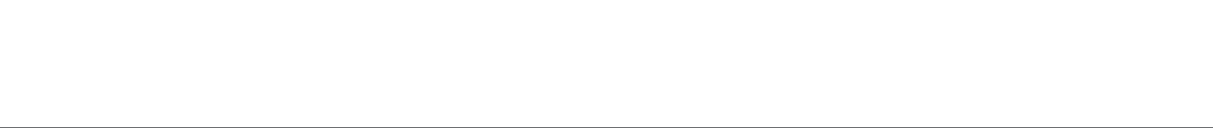
Frontiers in Built Environment |